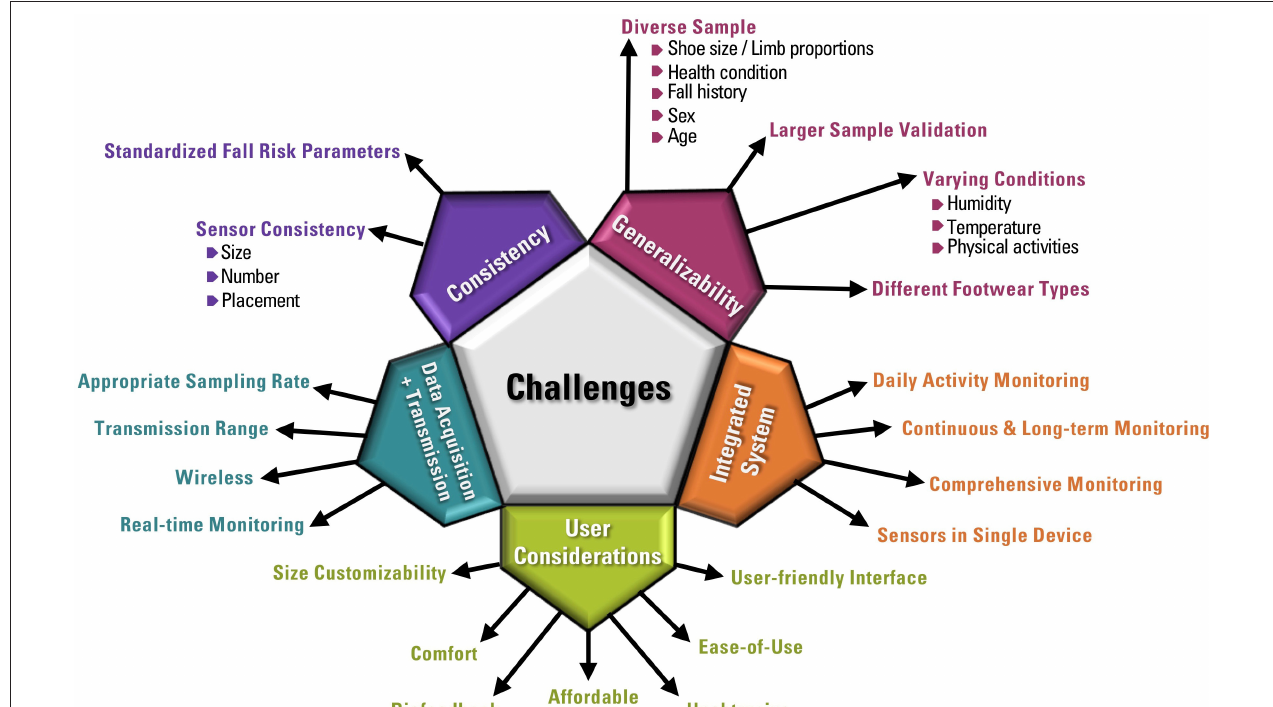
FIGURE 6 | Research challenges associated with fall risk assessment using wearable insole-based and inertial-based devices.